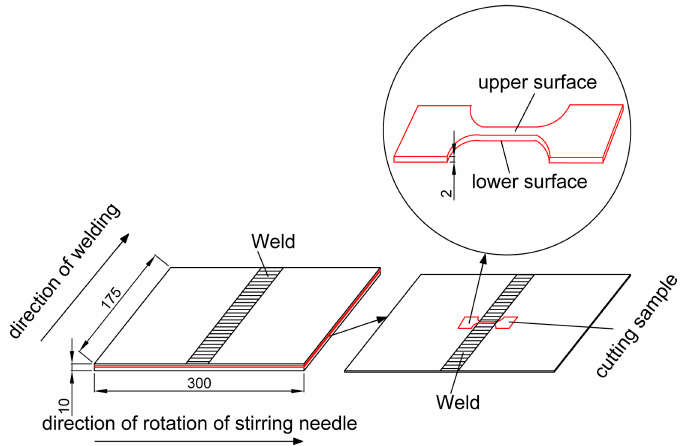
Figure 2. Schematic of the location of the Figure 2. S chematic of the location of the samples. Figure 2. S chematic of the location of the samples.